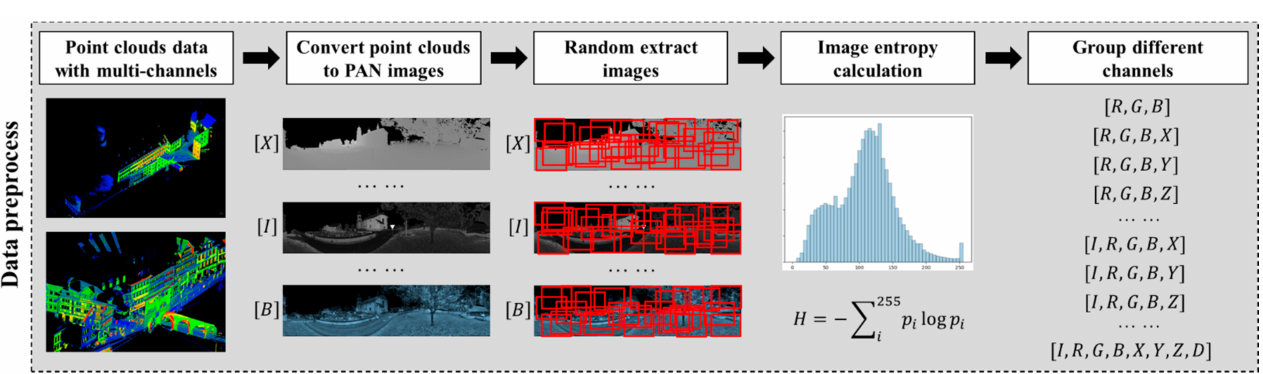
Figure 1. Detailed steps of the data